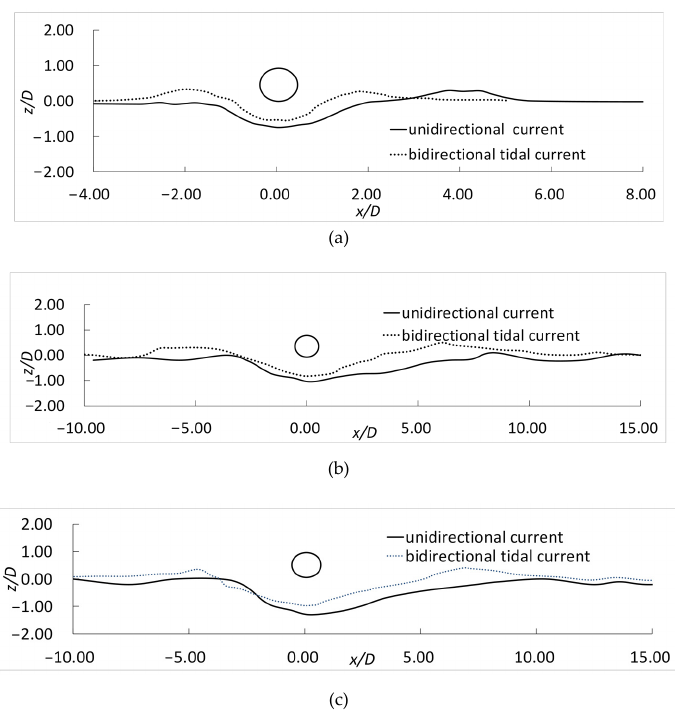
Figure 6. Comparisons of scour profiles under unidirectional and bidirectional tidal currents. ( a ) u 0 = u max = 0.3 m/s; ( b ) u 0 = u max = 0.4 m/s; ( c ) u 0 = u max = 0.5 m/s.